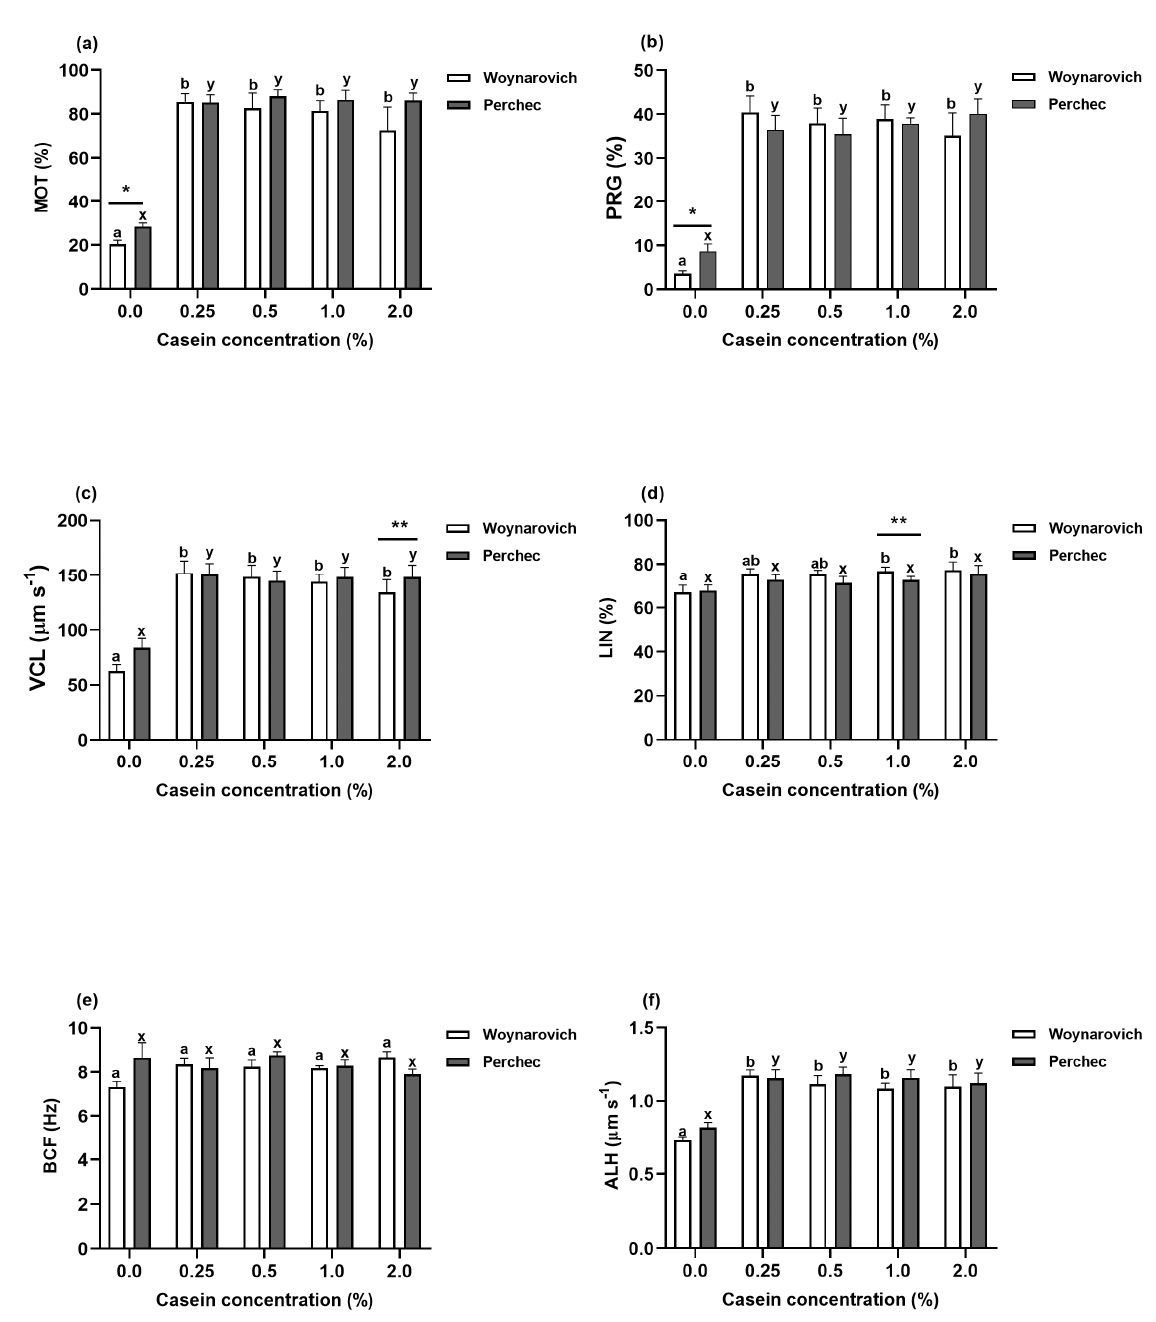
Figure 3. Percentages of motile sperm ( a ), progressively motile sperm ( b ), the curvilinear velocity of sperm ( c ), movement linearity ( d ), beat cross frequency ( e ), and amplitude of lateral head displacement ( f ) after activating ide ( Leuciscus idus, n = 5) sperm motility with Woynarovich and Perchec solutions with different casein concentrations. Results presented as mean ± SEM ( p < 0.05). Boxes marked with letters ( a , b ) indicate significant differences among Woynarovich solutions supple- mented with different casein concentrations, and boxes marked with letters (x,y) indicate significant differences among Perchec solutions supplemented with different casein concentrations. Asterisks indicate the level of statistical significance of values measured in Woynarovich and Perchec solutions at the same protein concentrations (* p < 0.05; ** p <